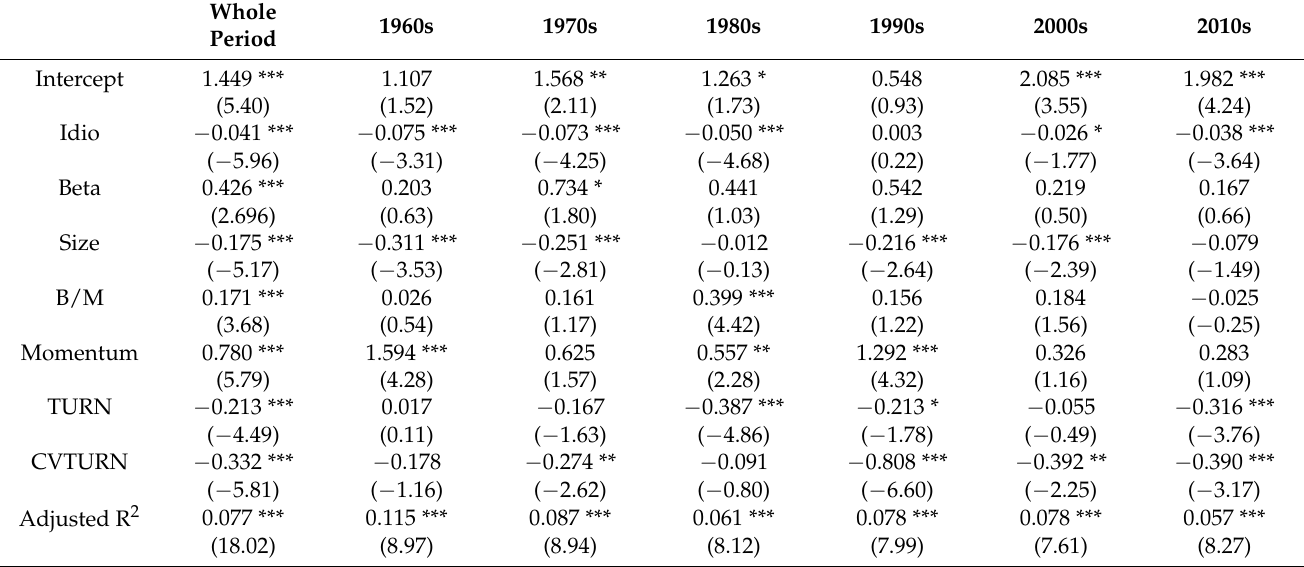
Table A2. This table reports the regression results of robustness tests when idiosyncratic risk is estimated by Carhart (1997) model. It reports the results of the firm-level Fama and MacBeth (1973) regressions of monthly stock returns on idiosyncratic risk for the period of July 1963 to December 2019. A stock should have at least 15 daily returns in a month to be included in the risk estimation. Stock-level market beta is estimated from 60-month rollover regressions. ME Size and B/M are size and book-to-market ratio in Fama and French (1992). Momentum is the compound gross return from month (t − 7) to (t − 2). TURN and CVTURN are the average volume turnover and coefficient of variance of TURN calculated over the past 36 months in Chordia et al. (2001). The idiosyncratic risk (Idio) is the standard deviation of regression residuals of daily stock returns in month t − 1. The Newey–West adjusted t-value is reported in parentheses. To avoid the effect of possibly spurious outliers, all explanatory variables below 0.1 (above 99.9) percentile are set equal to 0.1 (99.9) percentile. *, ** and *** denote the statistical significance level at 10%, 5% and 1%, respectively.